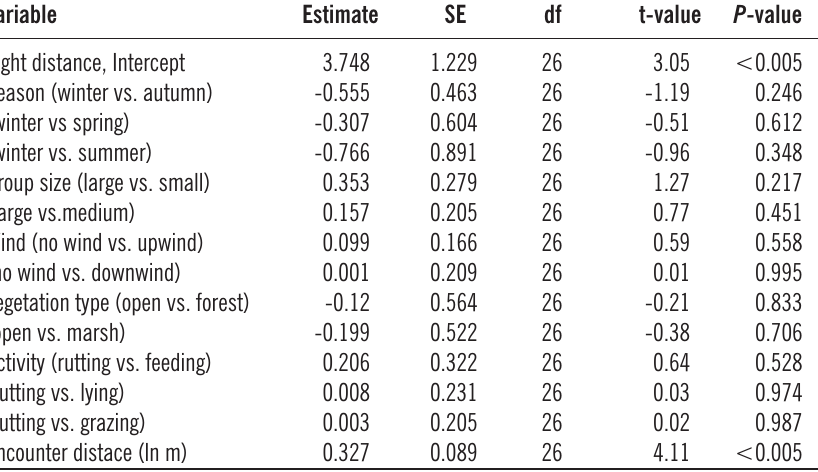
Table 2. Linear mixed-effects model for predicting flight-initiation distances (In transformed) of groups of wild forest reindeer and semi-domestic reindeer disturbed by anapproaching observer on foot/snowshoes in different areas in Finland and Norway in